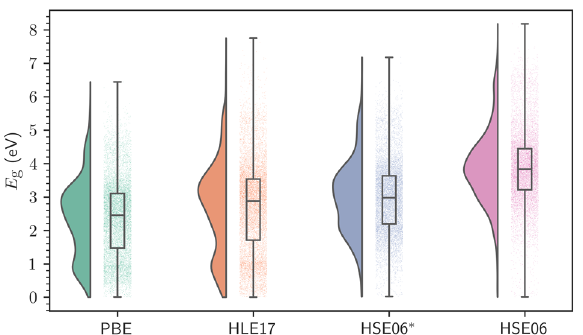
Fig. 1 Distribution of band gap data at four levels of theory. Raincloud plots (i.e., combined violin plot, box plot, and strip plot) for the DFT-computed band gaps, E g , of 10,720 structures in the QMOF Database at the PBE, HLE17, HSE06 * , and HSE06 levels of theory. The strip plots show all the data at that level of theory (jittered horizontally for ease-of-visualization). The box plots show the extrema (whisker tails), interquartile range (box boundaries), and median (horizontal line). The violin plots show the probability density of the